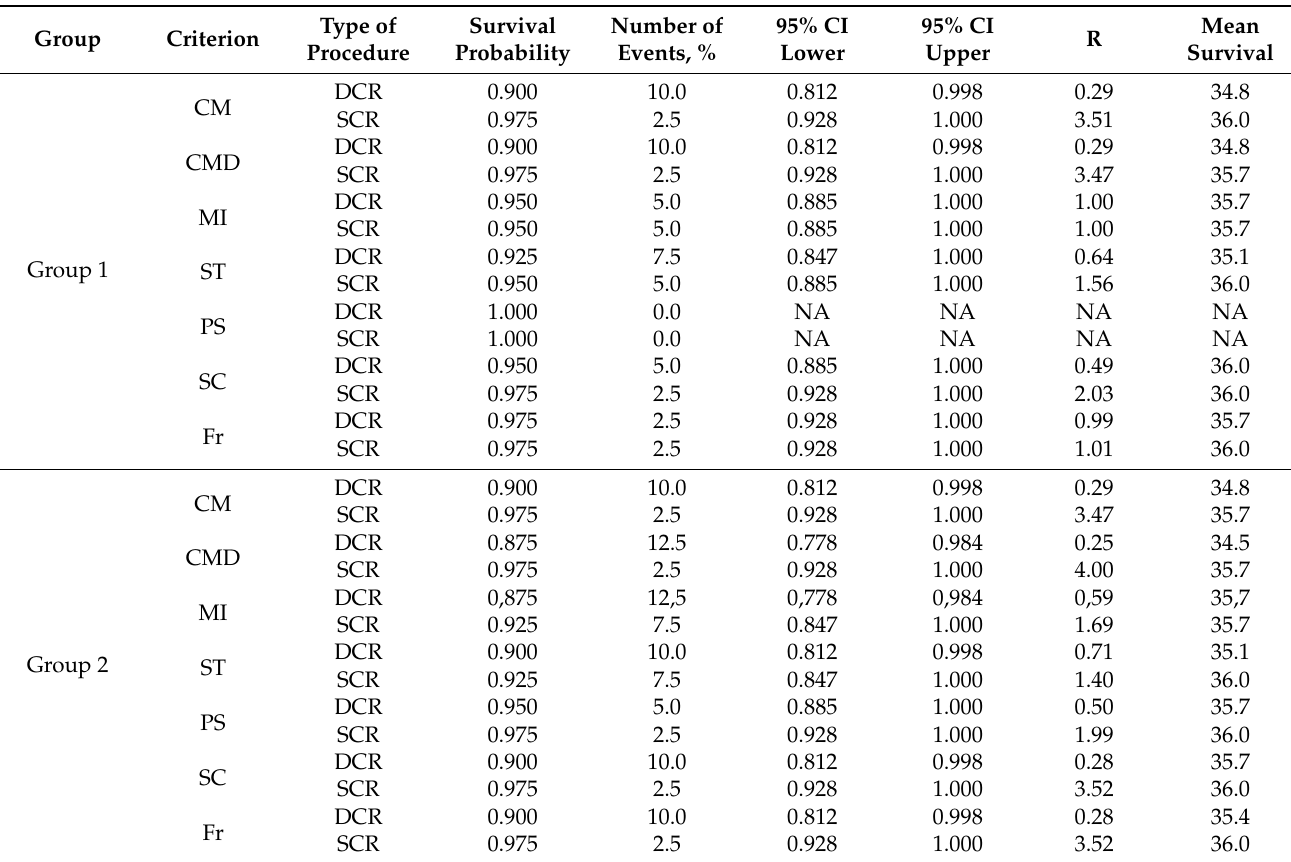
Table 2. Descriptive survival statistics based on the Kaplan–Mayer survival